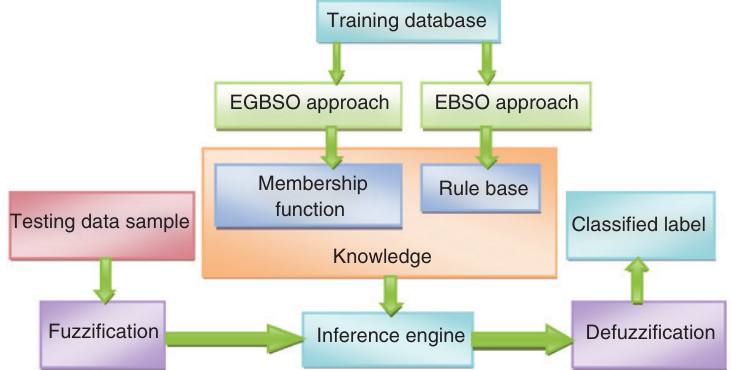
Figure 1: Block Diagram of the